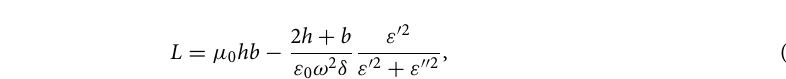
Figure 2. Refractive index n , κ , absorptance spectrum, and electromagnetic field contour of ( a ) VO 2 , ( b ) cWO 3 , and ( c ) MoO 3 at metallic (colored) state. The magnetic field is shown in contour and black array shows the electric field